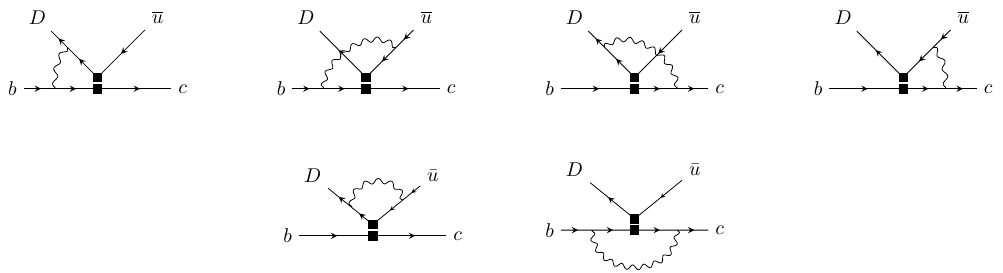
Figure 1 . One-loop α em -contributions to b → c ¯ uD transitions of the operator Q 2